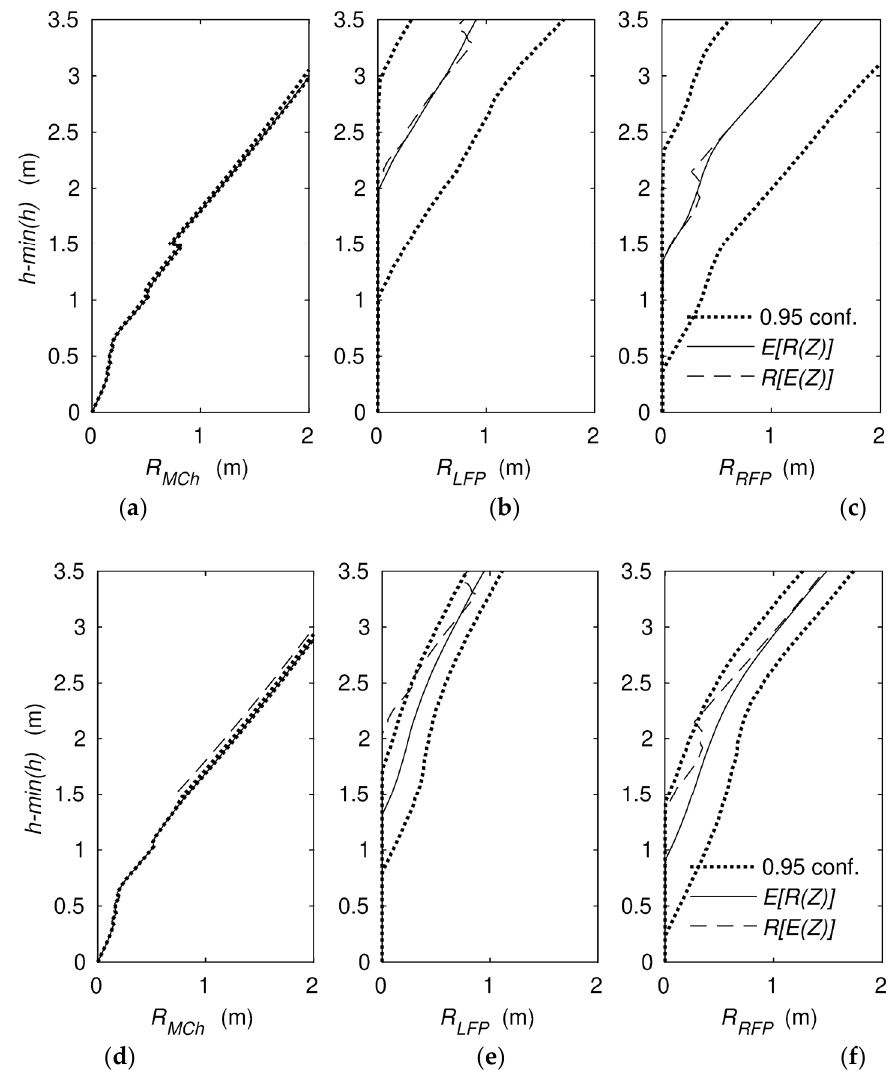
Figure 6. The hydraulic radius computed with and without the uncertainty for the cross-section next to the measurement point; ( a–c ) for the correlated DTM uncertainty; ( d–f ) for uncorrelated; R MCh (a or d), denotes hydraulic radius for the main channel, R LFP (b or e) and R RFP (c or f) for the left and right floodplain, respectively.